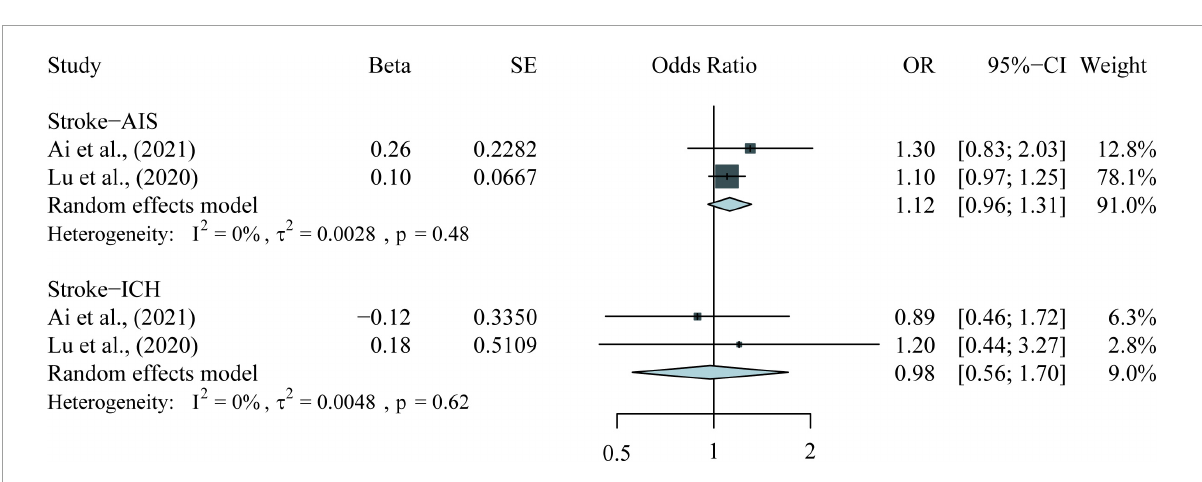
FIGURE3 Meta-analysis results for the association between long sleep duration and CVDs in MR studies. CVDs, cardiovascular diseases; MR, Mendelian randomization; AIS, any ischemic stroke; ICH, primary intracranial